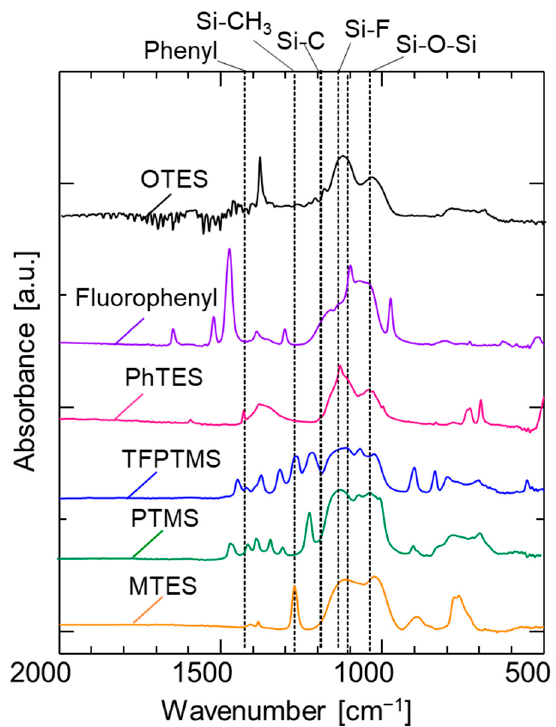
Figure 1. FT–IR spectra of various pendant–type organosilica films calcined at 300 °C under a N 2 atmosphere.